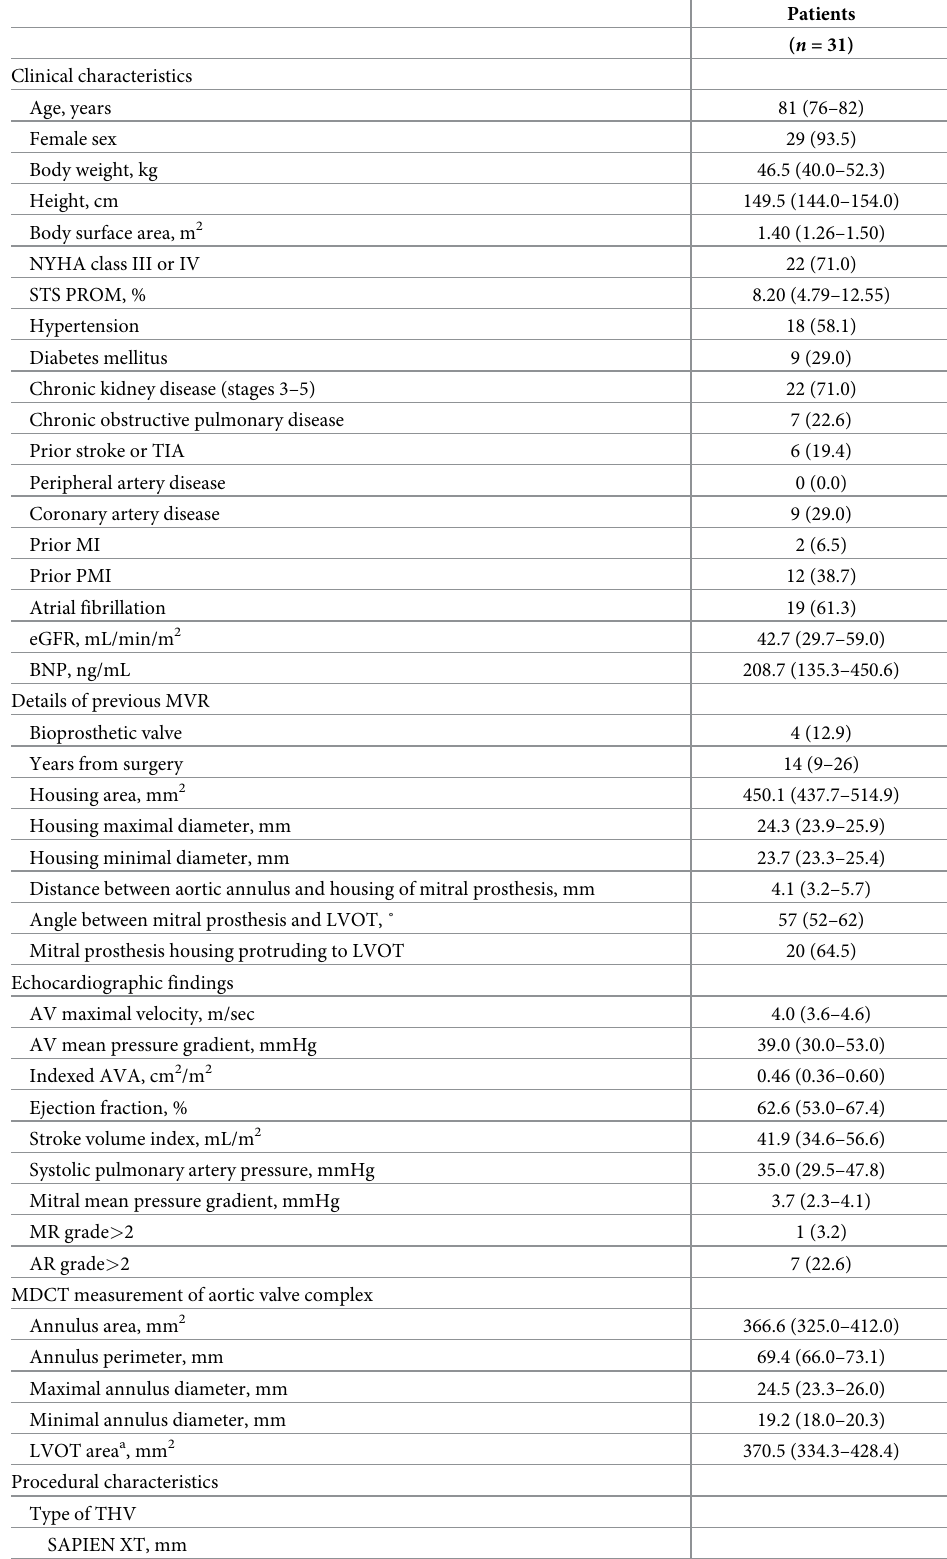
Table 1. Baseline